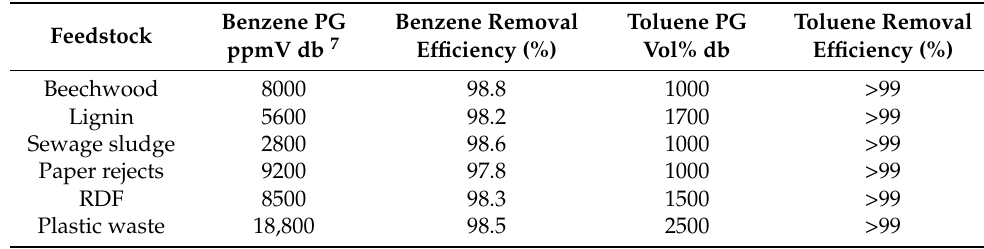
Table 5. The benzene and toluene removal efficiency from the product gas (PG) in the AREA at different gasification processes.